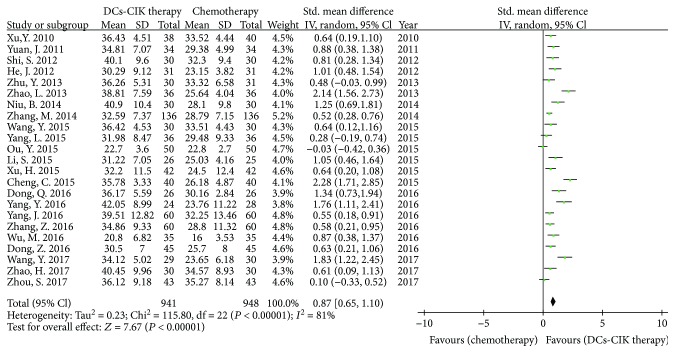
The analysis of CD4+ T cells between the two groups.